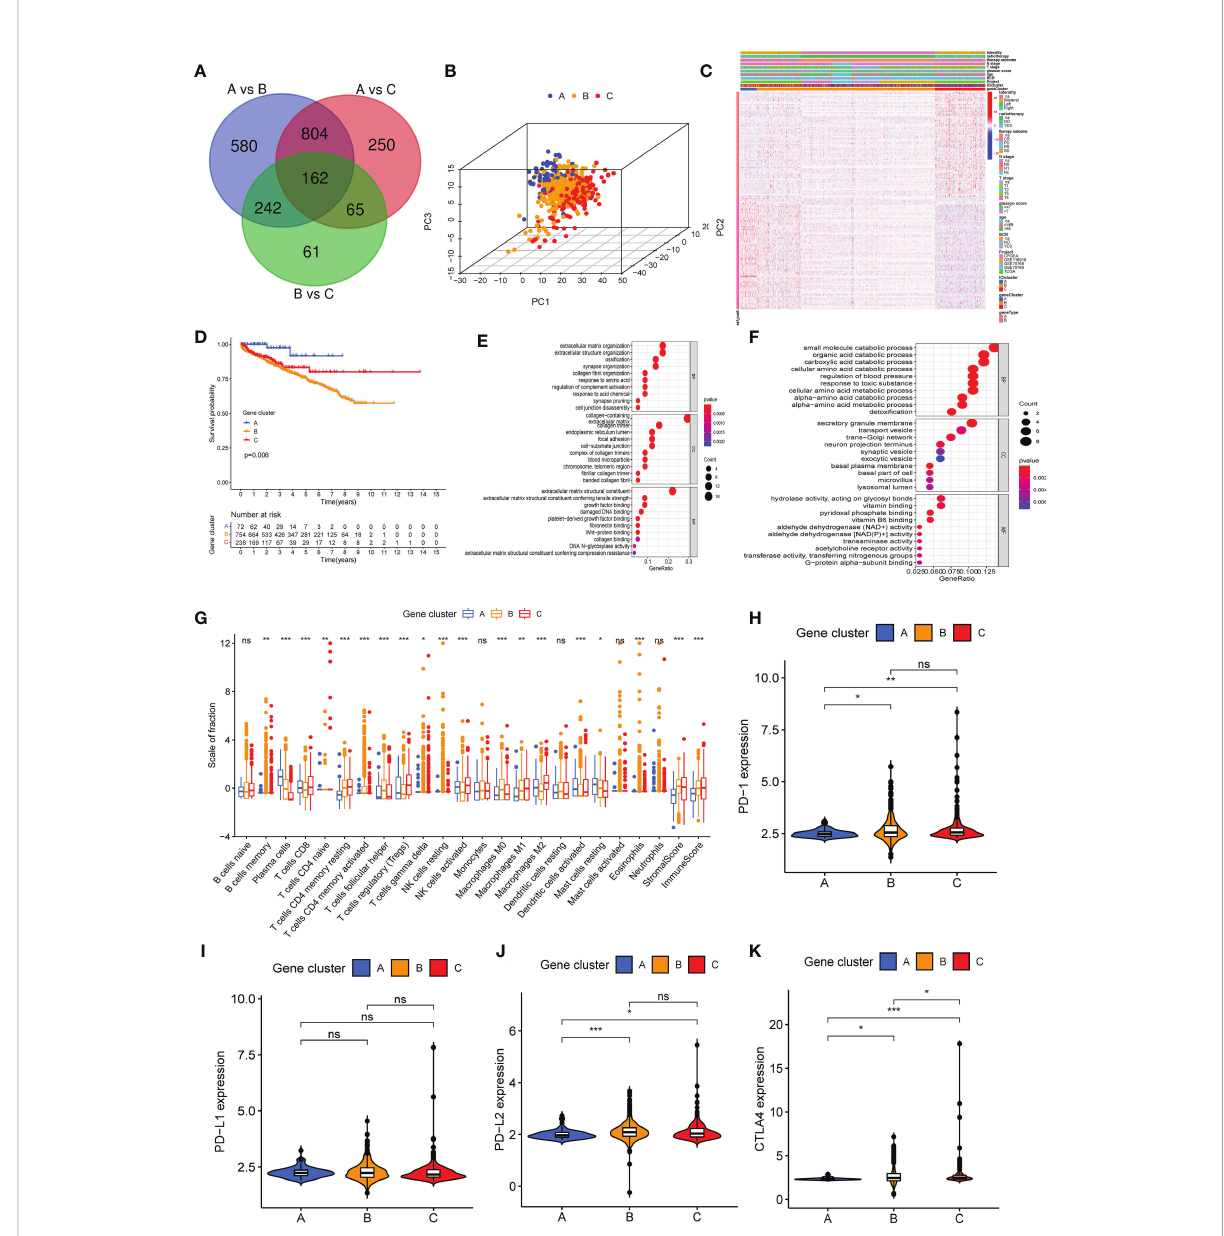
FIGURE 2 Three different genetypes were strati fi ed based on overlapping differentially expressed genes in three immune cell in fi ltration (ICI) clusters. (A) A total of 162 DEGs were screened from three ICI clusters. (B) A three-dimensional diagram of principal component analysis shows the distribution of the three gene clusters. (C) The heat map shows the distribution of 22 immune cells, immune score, and stromal score in the three gene clusters. (D) Kaplan – Meier curve was used to analyze the biochemical recurrence prognosis among three gene clusters (log-rank test, P = 0.006). (E, F) Gene Ontology enrichment analysis of genes in ICI genetype A (E) and ICI genetype B (F) . (G) The in fi ltration of 22 immune cells, immune score, and stromal score in patients in three gene clusters. (H – K) Difference in the expression of PD1 (H) , PD-L1 (I) , PD- L2 (G) , and CTLA4 (K) in three gene clusters. * P < 0.05, ** P < 0.01, *** P < 0.001, ns, no signi fi